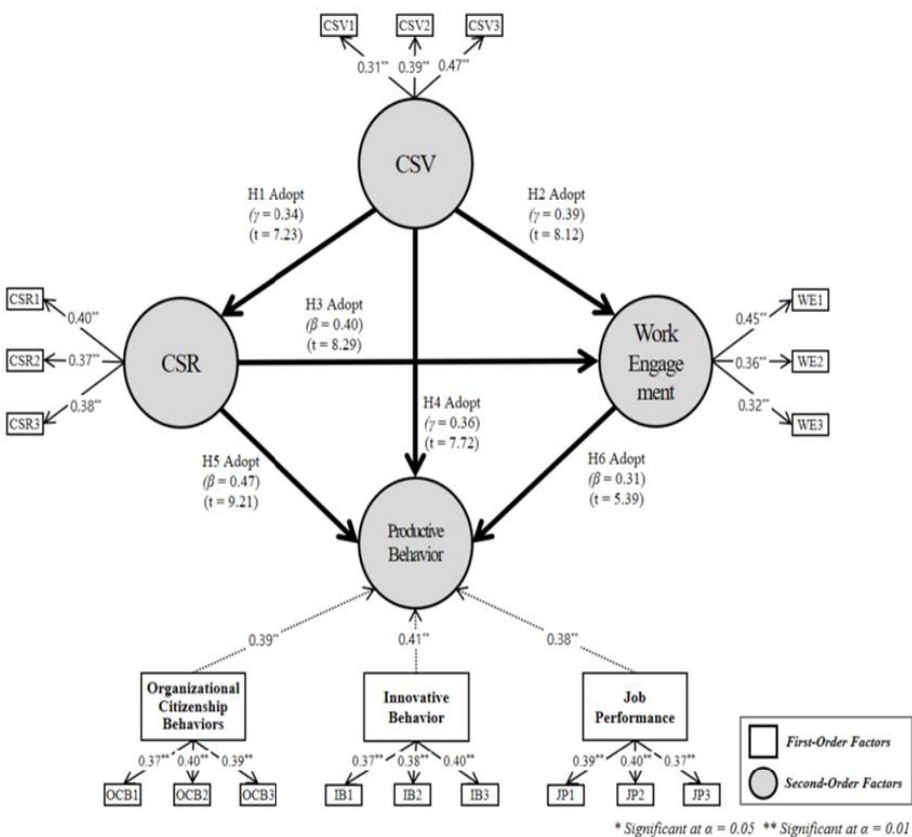
Figure 3. Results of hypothesis testing.